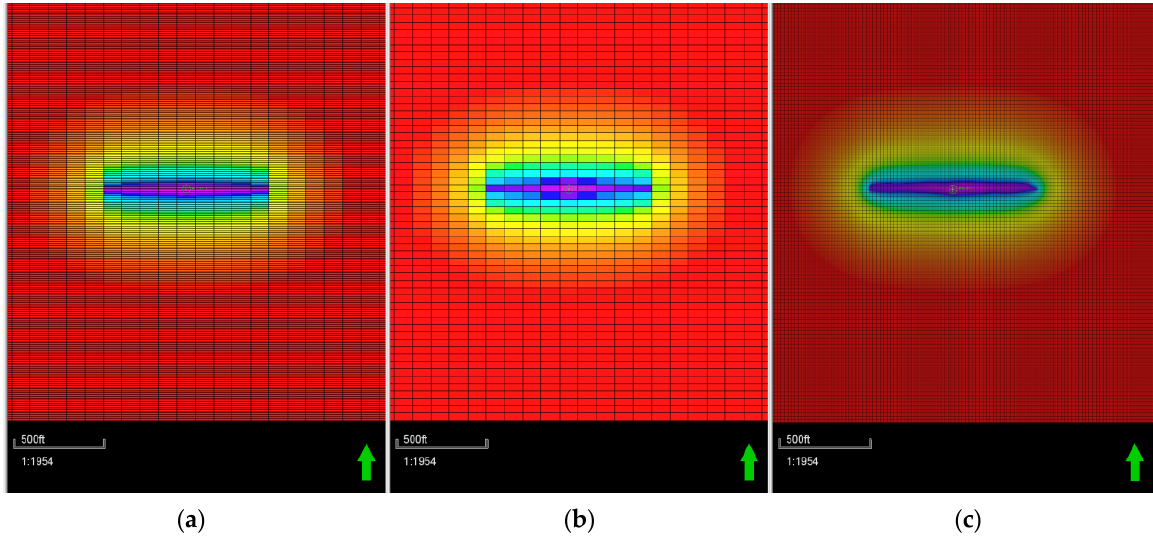
Figure 7. Pressure map in late time for ( a ) Base Case, ( b ) Coarse Case, and ( c ) Reference.